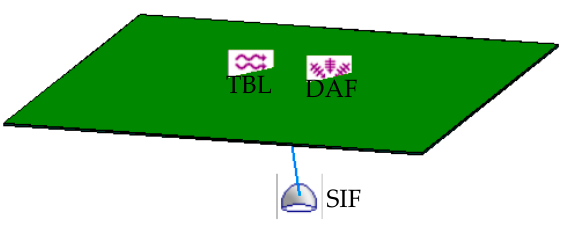
Figure 16. The model of Corcos model and DAF.